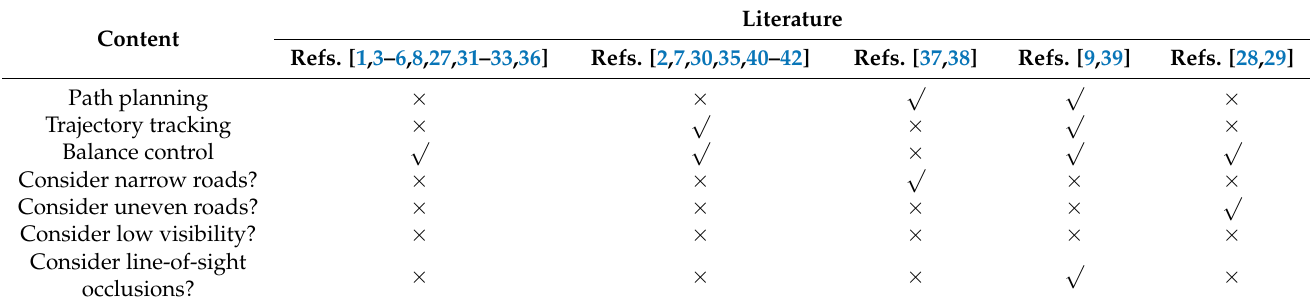
Table 1. Relationship between the contents of the references and the proposition of this